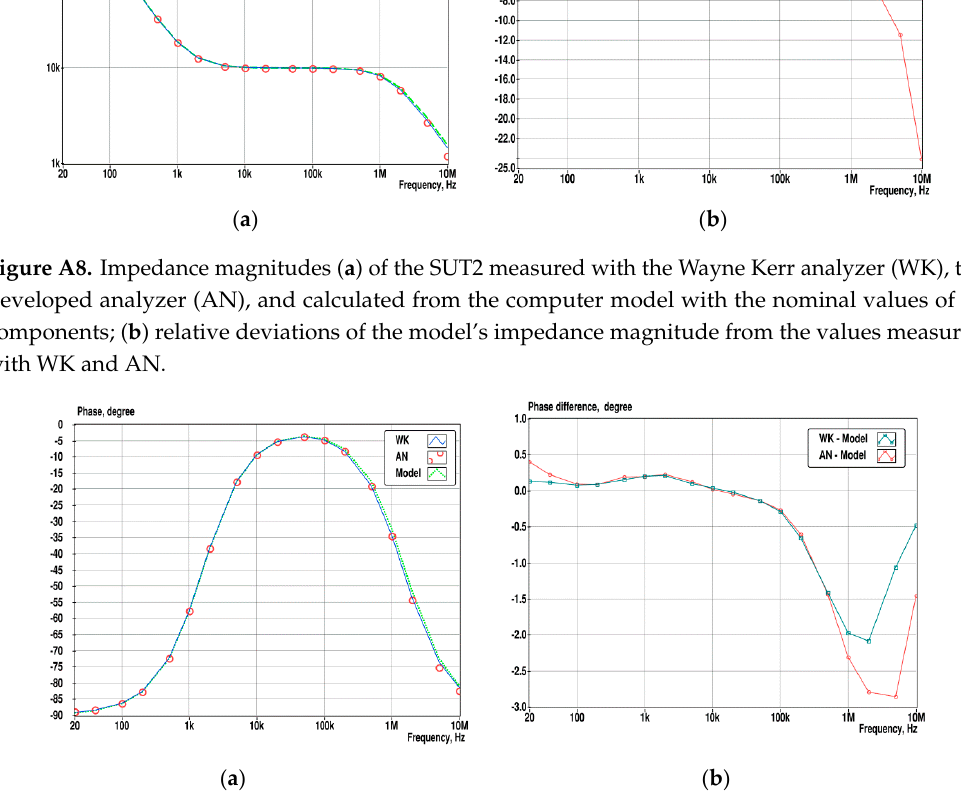
Figure A9. Impedance phases ( a ) of the SUT2, measured with the Wayne Kerr analyzer (WK), the developed analyzer (AN), and calculated from a computer model at the nominal values of its components. Deviations of phase values ( b ), measured with WK and AN, from the modeled